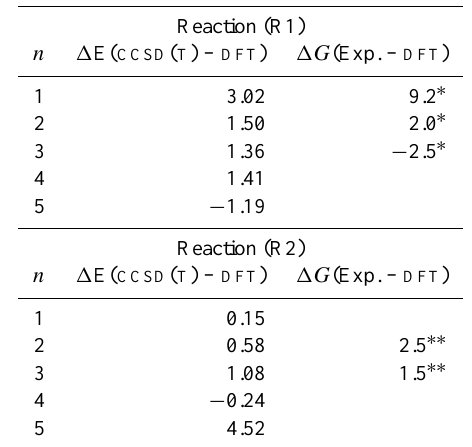
Table 2. Free energy differences of Reactions (R1) and (R2) from various methods. “ CCSD ( T )” refers to UCCSD ( T )- F 12/ VDZ - F 12 calculations on CAM - B 3 LYP structures. Units arekJ/mol. ∗ and ∗∗ indicate data from Arshadi and Kebarle (1970) and Fehsenfeld and Ferguson (1974)